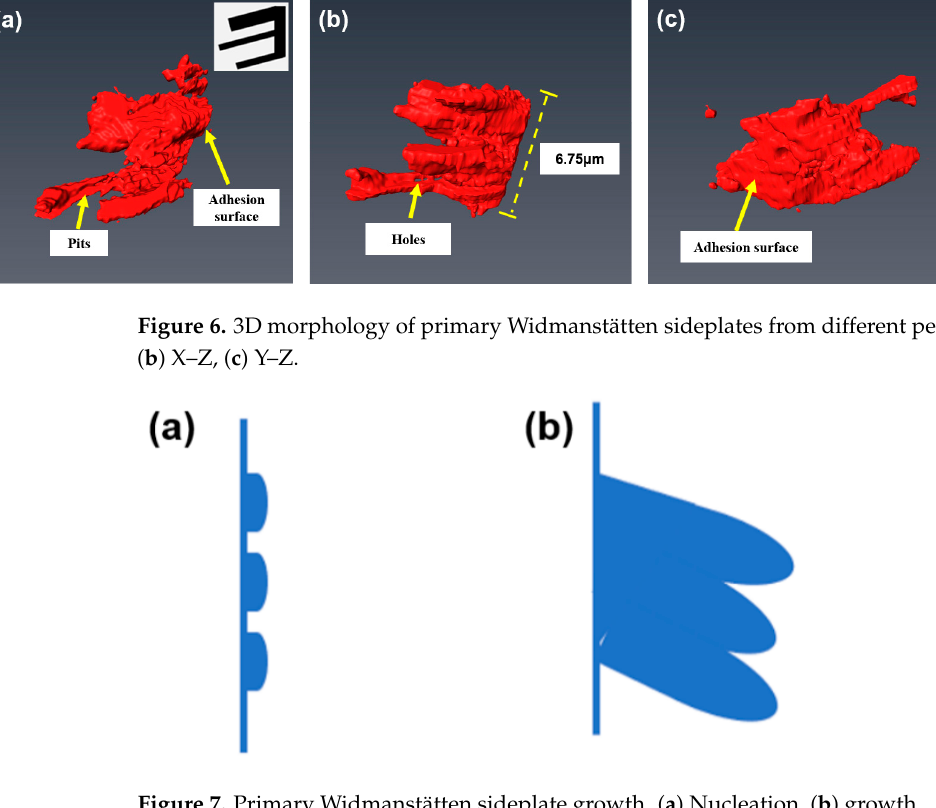
Figure 7. Primary Widmanstätten sideplate growth. ( a ) Nucleation, ( b )